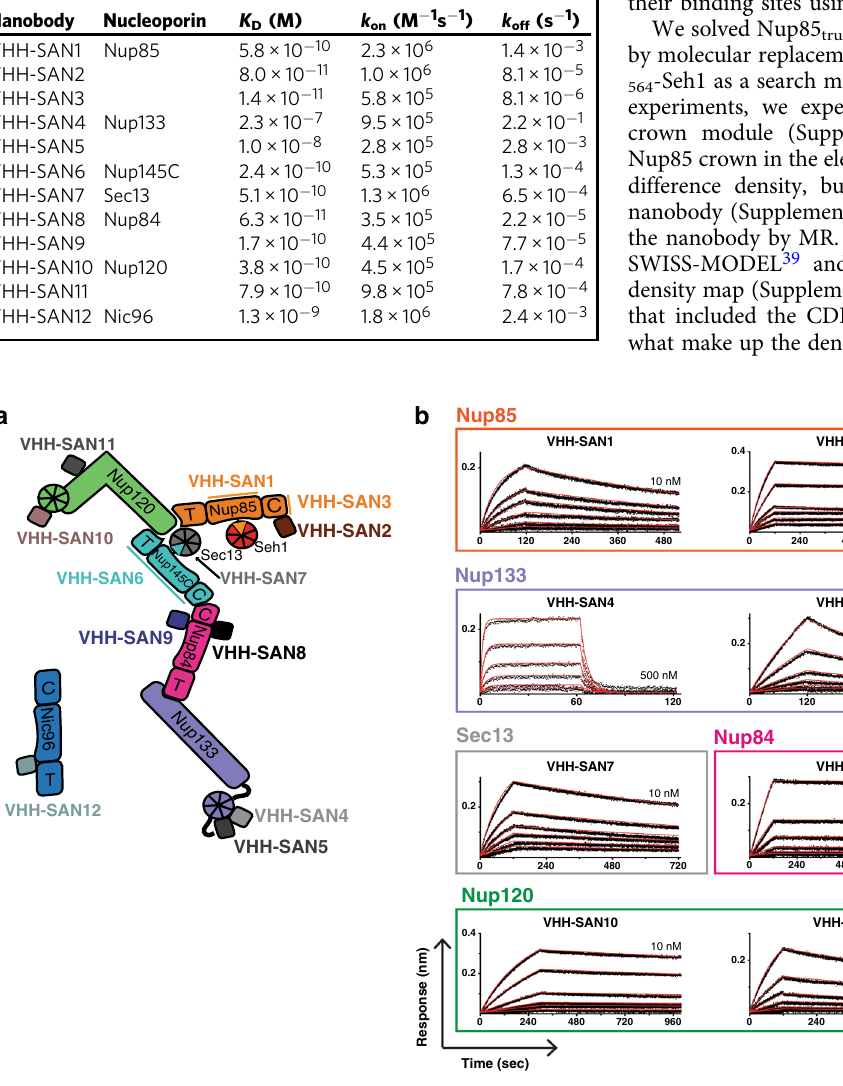
Fig. 2 Bio-layer interferometry of nanobody-nup binding. a Schematic of the Y complex and Nic96 with the nanobody library. b Binding curves showing association and dissociation kinetics for each nanobody-nup pair. Nanobodies with a biotinylated C-terminal Avi-tag were fi xed (ligand) and nups were used as analytes. Curves were corrected for buffer background. Each set of curves is a twofold dilution series from the highest concentration listed on each plot. Experimental data are shown as black dotted lines with red lines indicating globally fi tted curves. Axis labels for all plots are indicated in the bottom